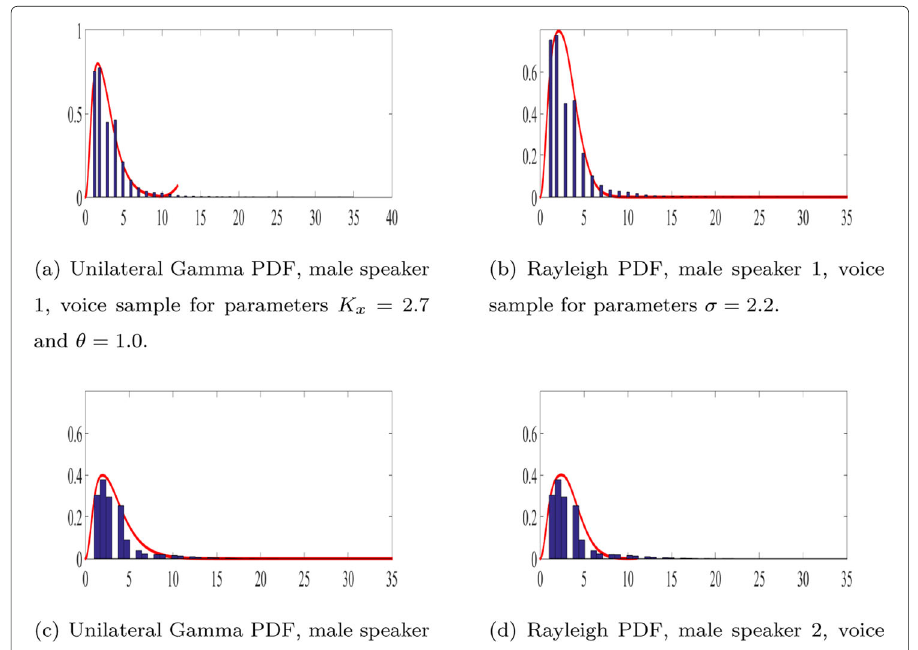
Fig. 2 PDF curves of Rayleigh and unilateral gamma distributions superimposed to histograms generated from voice samples of male speakers